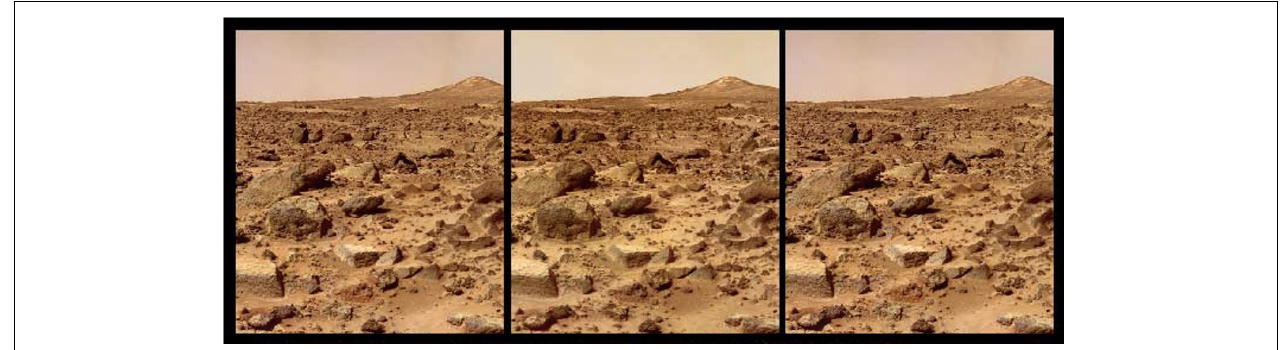
FIGURE 3 | Stereogram image of the surface of Mars in a triple (R-L-R) format designed for easy free-fusion. Note that the monocular information before free-fusion makes it explicit that the image is a flat frontoparallel 2D surface, whereas the 2D texture information suggests a roughly uniform gradient in depth. The valid disparity pairing shows that the gradient is, in fact, strikingly non-uniform, with an early rise and a drop back down before rising again into the distance. The inverse pairing reveals a strong interaction between the 2D form information and the stereoscopic disparity information, in that the inverse depth image does not settle into a coherent structure. This variety of flat and depth impressions from the same pair of images clearly indicates that the perceived depth is illusory.